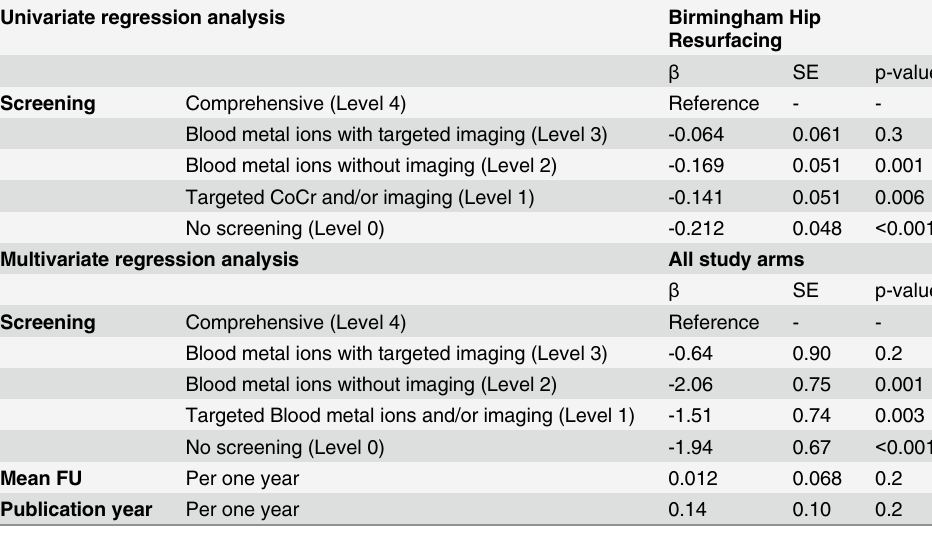
Table 4. Results of the metaregression analysis in the